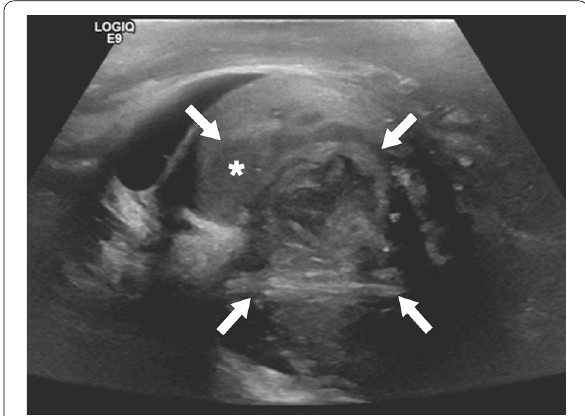
Fig. 9 Mass-forming testicular abscess. A 69-year-old male who presented with recent onset of right testicular pain and palpable mass. Gray scale US image shows a heterogenous mass with ill-defined borders and central cystic areas. The imaging appearance was concerning for a paratesticular sarcoma (arrows) infiltrating testicular parenchyma (asterisk). Orchiectomy revealed no evidence of malignant disease but organized testicular abscess with paratesticular extension